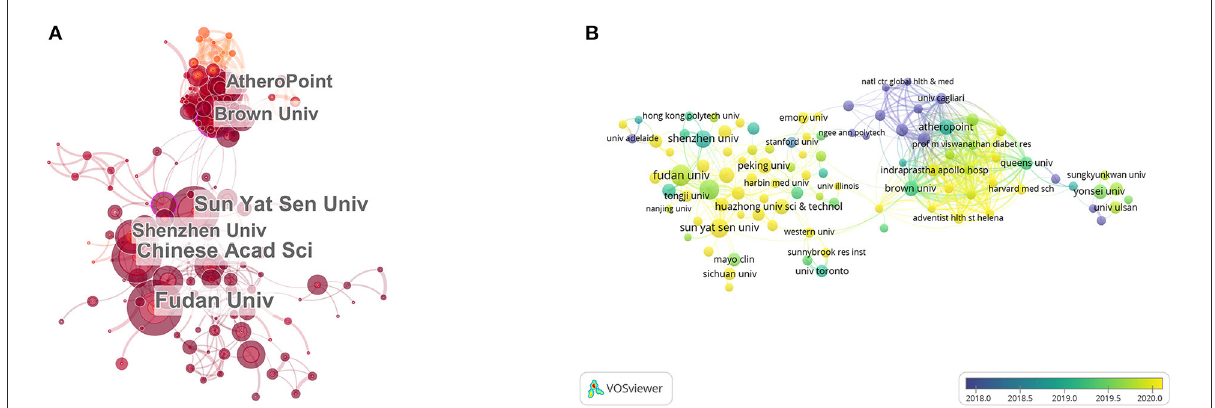
FIGURE4 Distribution of publications on the application of artificial intelligence in the field of ultrasound in all institutions. (A) The network of institutions by Citesapce. (B) The average annual publication number network of institutions by VOSviewer. The size of the circle indicates the number of publications, green and blue circles indicate more past publications, and yellow circles indicate more recent publications.